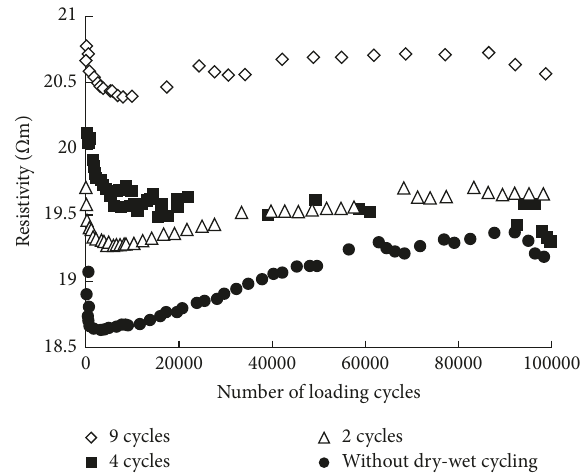
Figure 6: Effect of dry-wet cycles on the soil sample resistivity.